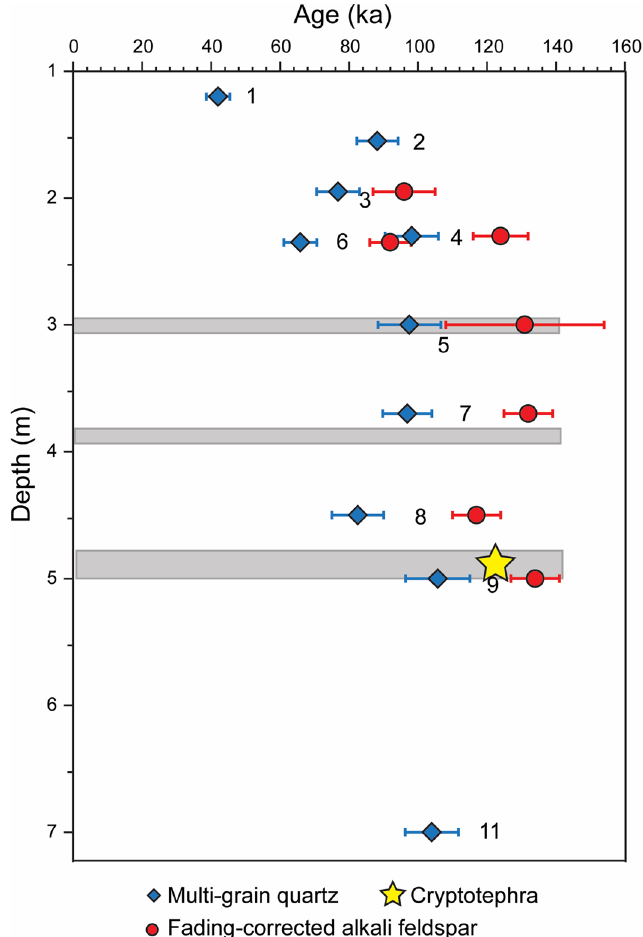
Figure 4. Luminescence ages as a function of depth in the sediment profile of Nahal Aqev. Horizontal bands show the archaeological layers 7, 9 and 11 (from top to bottom) and the star shows the level and estimated age of the cryptotephra (see below). Figure 4 was prepared by N.